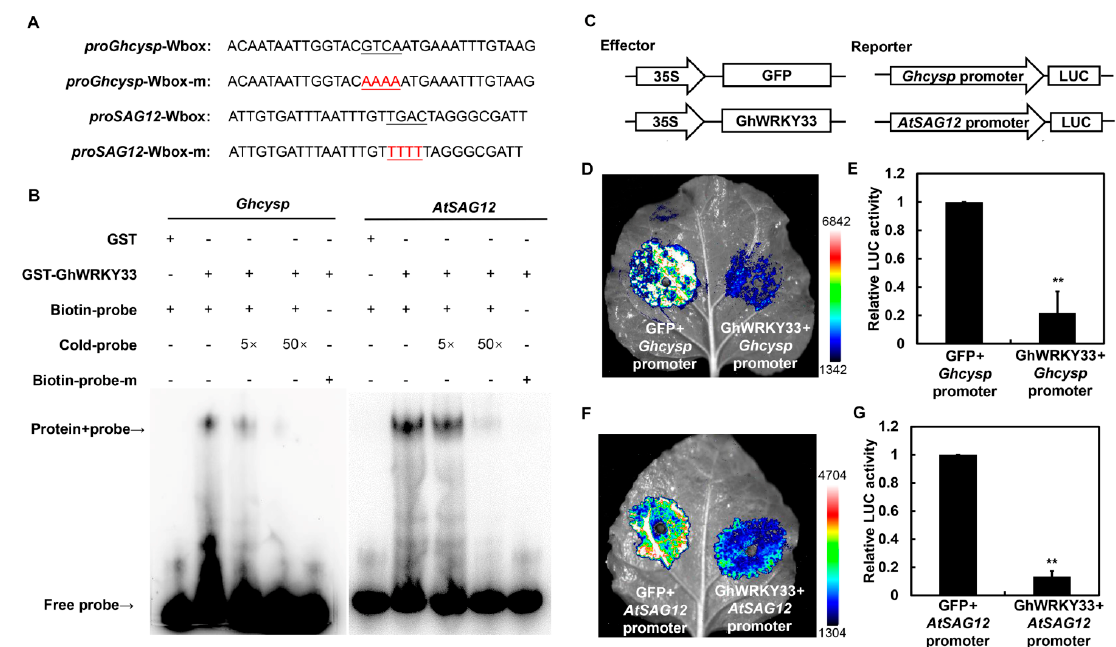
Figure 3. GhWRKY33 binds directly to the promoters of SAGs and suppresses their expression. ( A ) Probe sequences of Ghcysp and AtSAG12 for the EMSA assays. ( B ) Binding of GhWRKY33 to the W-boxes in the promoters of Ghcysp and AtSAG12 in EMSA assays. “–” indicates absence, while “+” indicates presence. ( C ) Structure of reporter and effectors used in transient dual-luciferase reporter system. ( D , E ) GhWRKY33 suppresses Ghcysp expression in a transient dual-luciferase reporter system. The LUC/REN ratio of the combination of pGreenII-62-SK empty vector and Ghcysp was set as 1. ( F , G ) GhWRKY33 suppresses AtSAG12 expression in transient dual-luciferase reporter system. The relative LUC activity of the combination of pGreenII-62-SK empty vector and AtSAG12 was set as 1. Data from six biological replicates were analyzed by ANOVA, and asterisks indicate significant differences (** p < 0.01).